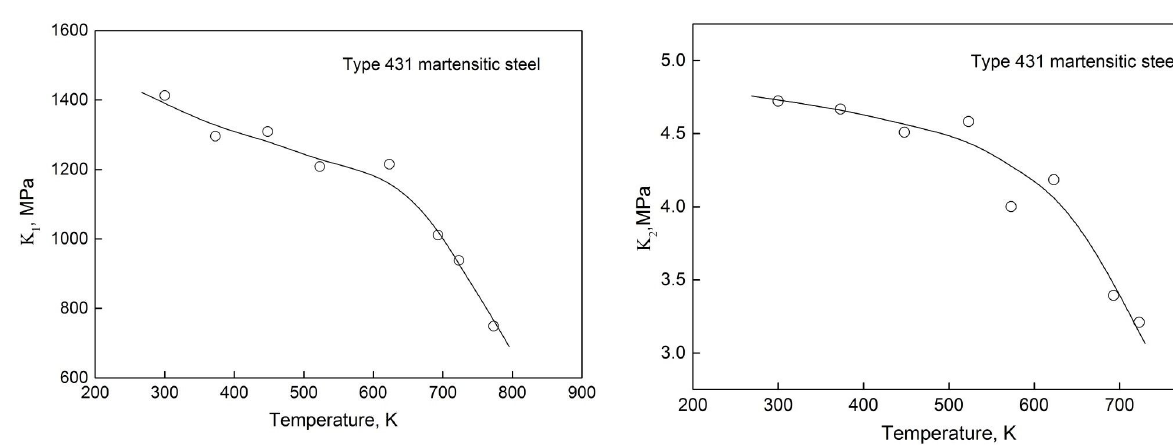
Figure 15: Variation of Ludwigson work hardening parameter K 2 with temperature for the AISI 431 steel.